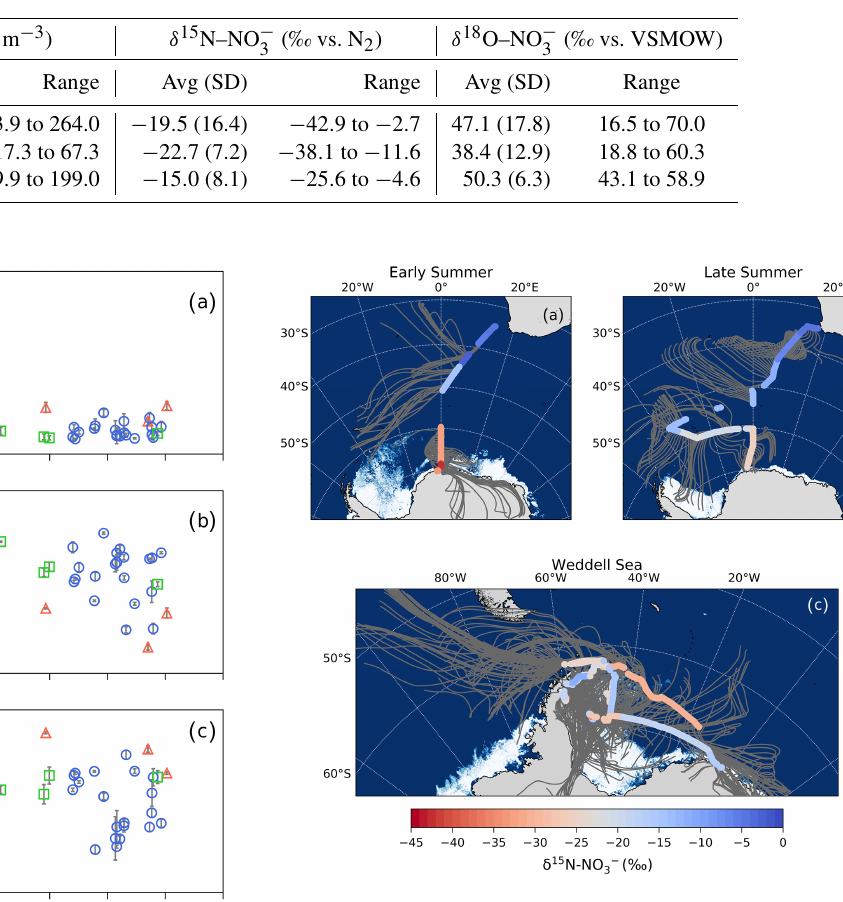
Figure 2. The 72h AMBTs (grey lines) computed for each hour of the voyage when the HV-AS was operational for more than 45min of the hour during early summer (a) , during late summer (b) and in Figure 1. (a) The average ( ± 1SD) coarse-mode ( > 1µm) nitrate the Weddell Sea (c) . The colour bar represents the weighted average concentration [NO − ] (ngm − 3 ) and the weighted average ( ± 1SD) 3 δ 15 N of coarse-mode ( > 1µm) atmospheric nitrate ( δ 15 N–NO − δ 15 N (b) and δ 18 O (c) of atmospheric nitrate ( δ 15 N–NO − (‰ vs. Individual AMBTs for each aerosol sample from the Weddell Sea 3 N 2 ) and δ 18 O–NO − (‰ vs. VSMOW), respectively), as a function are shown in Fig. S1 in the Supplement. The white area represents 3 of latitude ( ◦ S). Early and late summer latitudinal transects are de- the location of the sea ice determined using satellite-derived sea noted by the red triangles and green squares, respectively. Weddell ice concentration data, obtained from passive microwave sensors Sea samples are denoted by blue circles. Where error bars ( ± 1SD) AMSR2 (Advanced Microwave Scanning Radiometer 2; Spreen et are not visible, the standard deviation is smaller than the size of the al., marker.